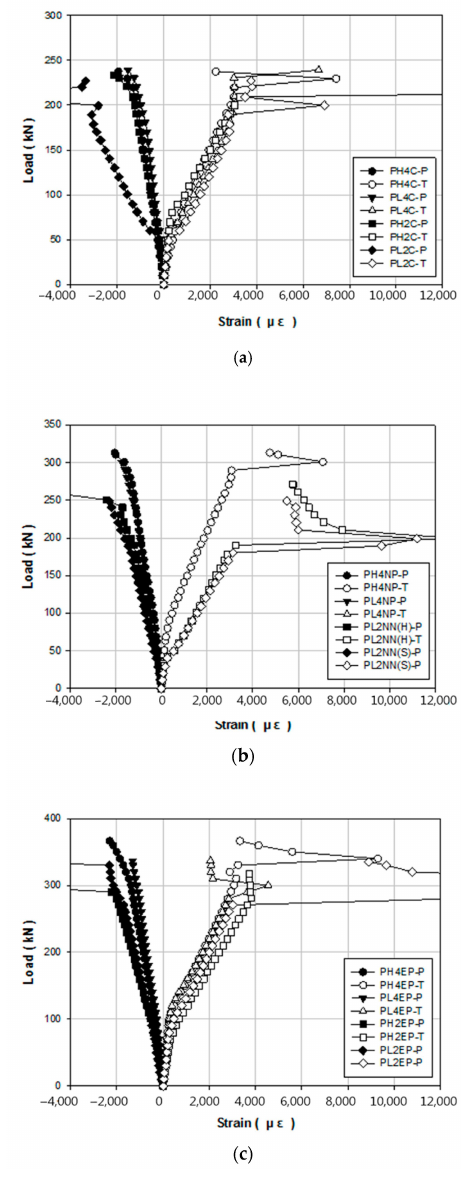
Figure 12. Reinforced bar load–strain responses for different strengthening methods: ( a ) PSC (control), ( b ) NSM, and ( c )